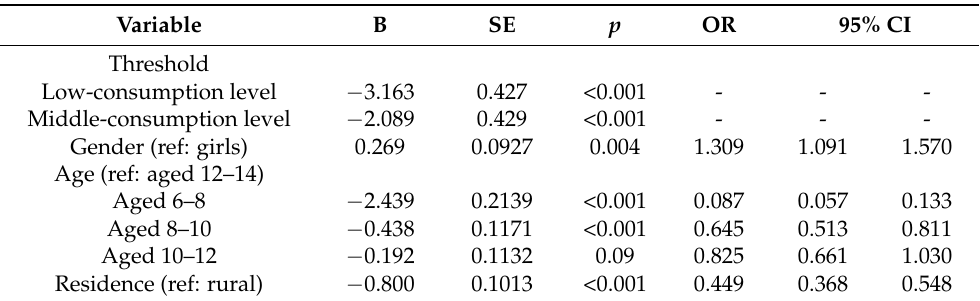
Table 6. Ordinal logistic regression of association between sugar consumption level and demography statistic among